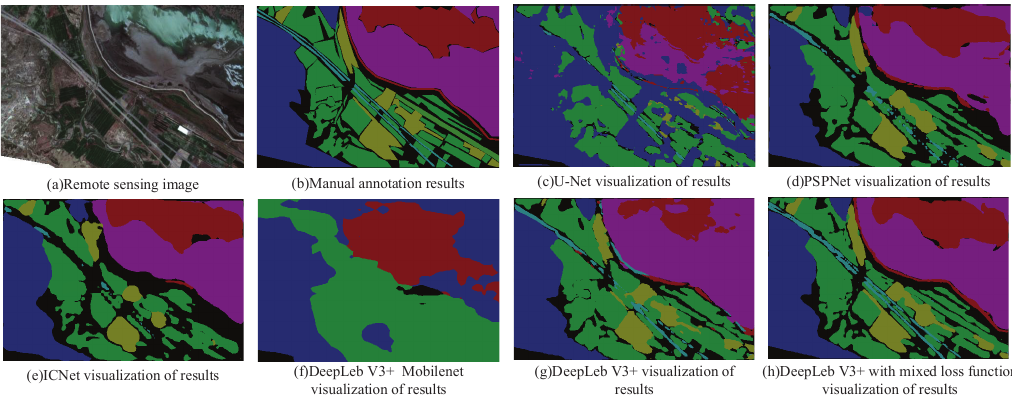
Figure 12. Partial visualizations of different